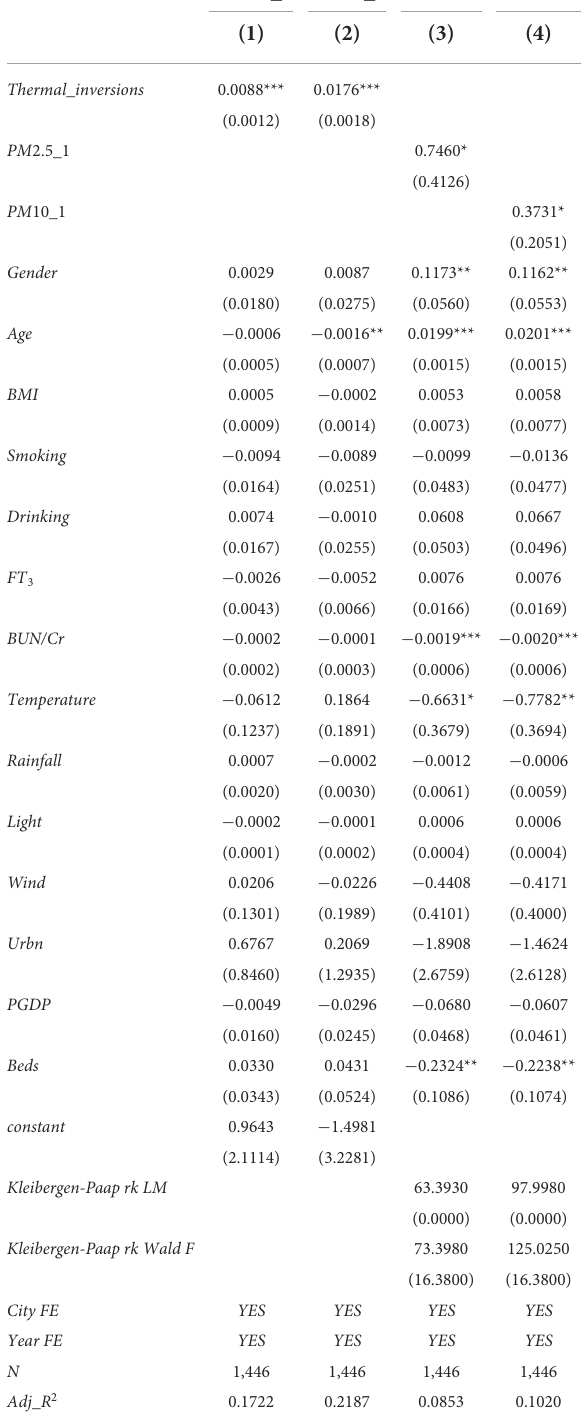
TABLE 3 Effects of air pollution on cardiovascular health [Instrumental variable (IV) estimation model].